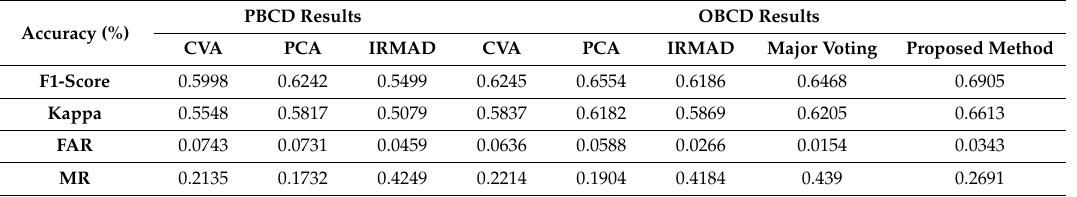
Table 2. Accuracy assessment of change detection results of the second experiment.